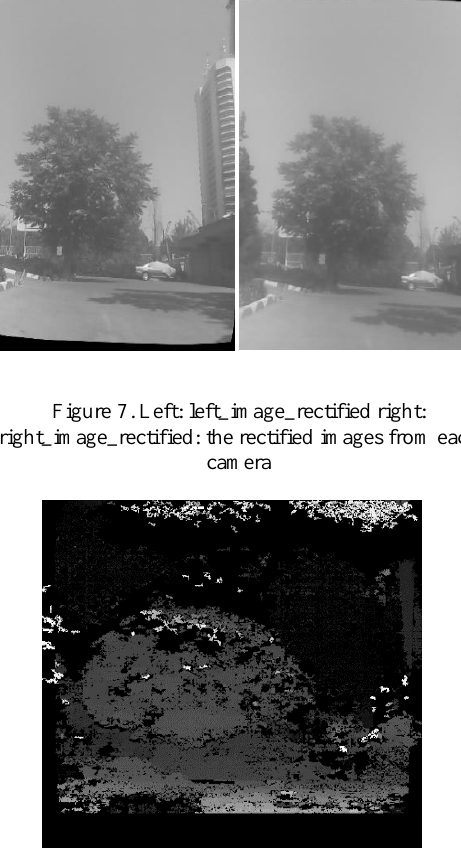
Figure 8. The resulting disparity image